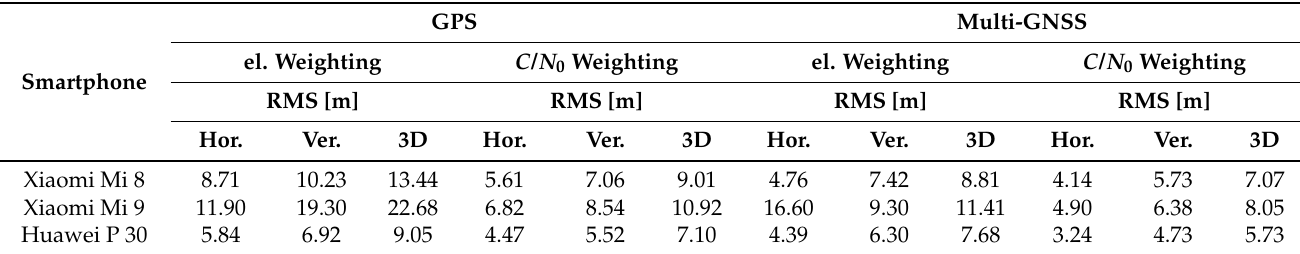
Table 4. Horizontal, vertical, and 3D positioning RMS error statistics for multi-GNSS and GPS solutions with both elevation and C / N 0 -dependent weighting schemes.